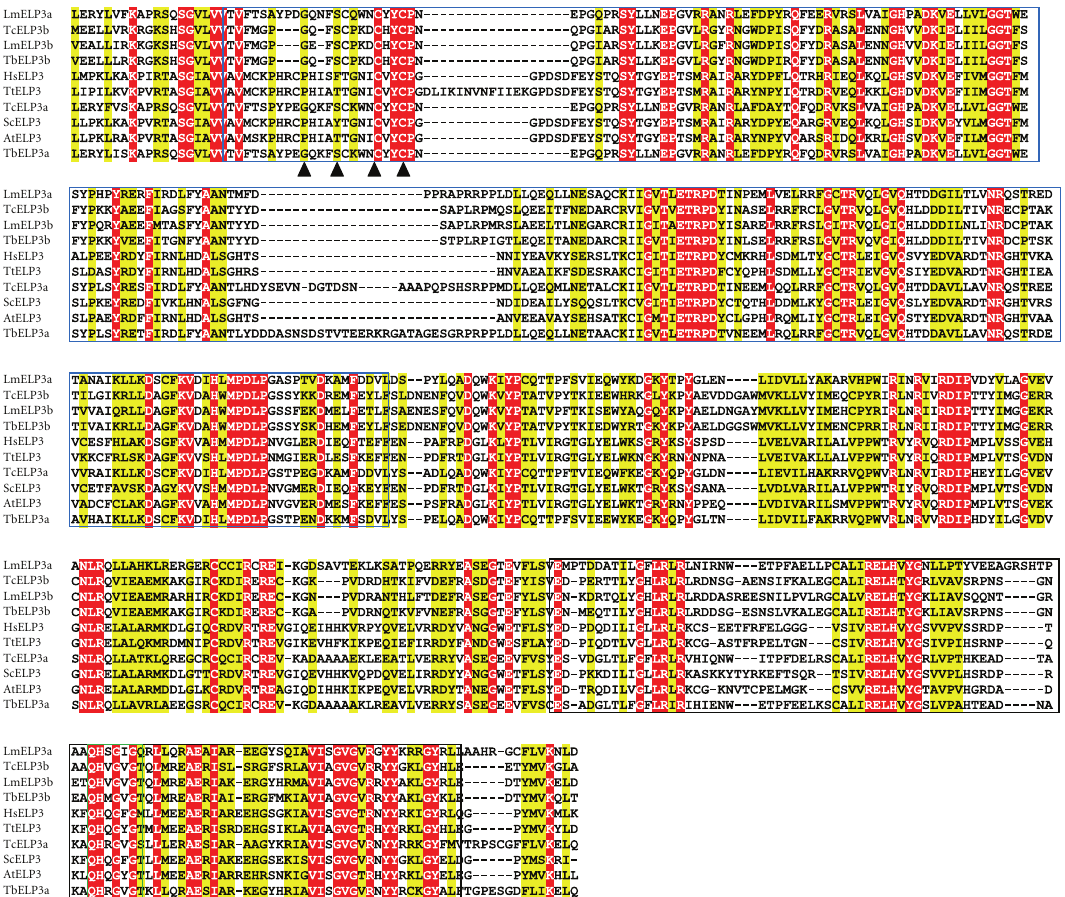
Figure 2: GNAT family histone acetyltransferases orthologues in trypanosomatids. Multiple sequence alignments of the core acetyltransferase domains from Tritryps and other organisms. Sequences were aligned with ClustalX2 followed by manual adjustment and illustrated with ESPript 2.2. Identical residues are white on red background, and residues shared by some organisms are black on yellow background. Radical SAM domain (blue box) and GNAT-type acetyltransferase domain (black box) are indicated. Motif A is marked with a green box. Arrowheads indicate the Cys residues that are part of the Fe-S cluster in the SAM domain. Tb, Trypanosoma brucei ; Tc, Trypanosoma cruzi ; Lm, Leishmania mayor; At, Arabidopsis thaliana ; Hs, human; Sc, Saccharomyces scerevisiae: Tt , Tetraymena thermophila.